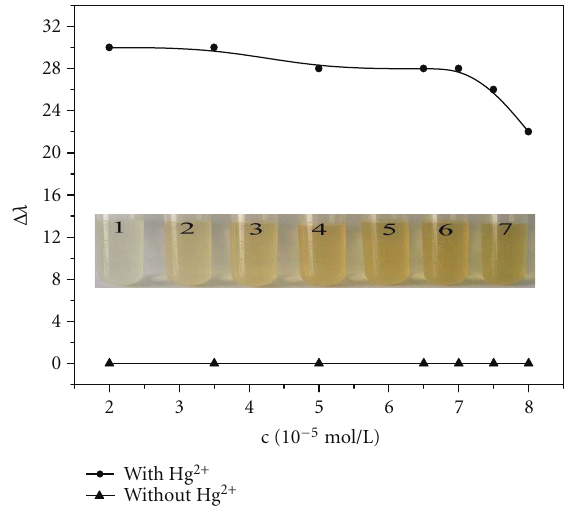
Figure 4: E ff ect of the AgNPs concentration. Concentration: AgNPs ( × 10 − 5 mol/L): 2.0, 3.5, 5.0, 6.5, 7.0, 7.5, 8.0, respectively; Hg (II) ion: 6.0 × 10 − 6 mol/L; HAc-NaAc bu ff er (pH 5.6). The inset picture displays color change with di ff erent concentration of